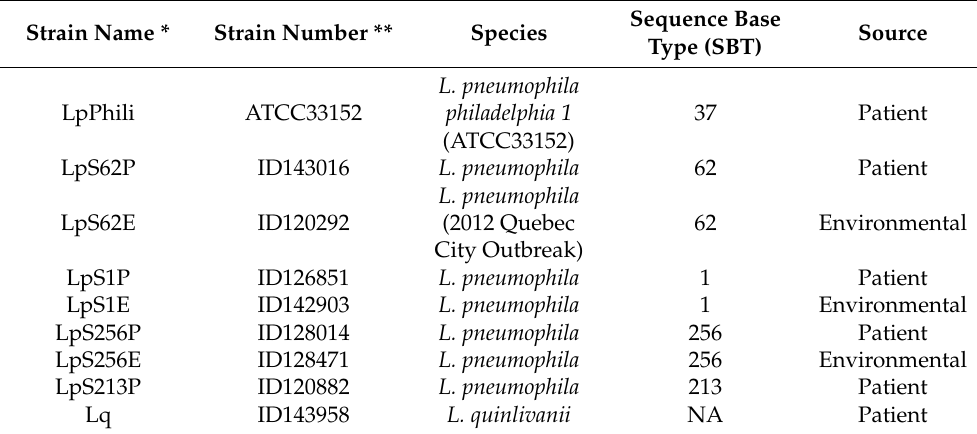
Table 1. Information on the species, the sequence base type, and the source of the Legionella strains used in this